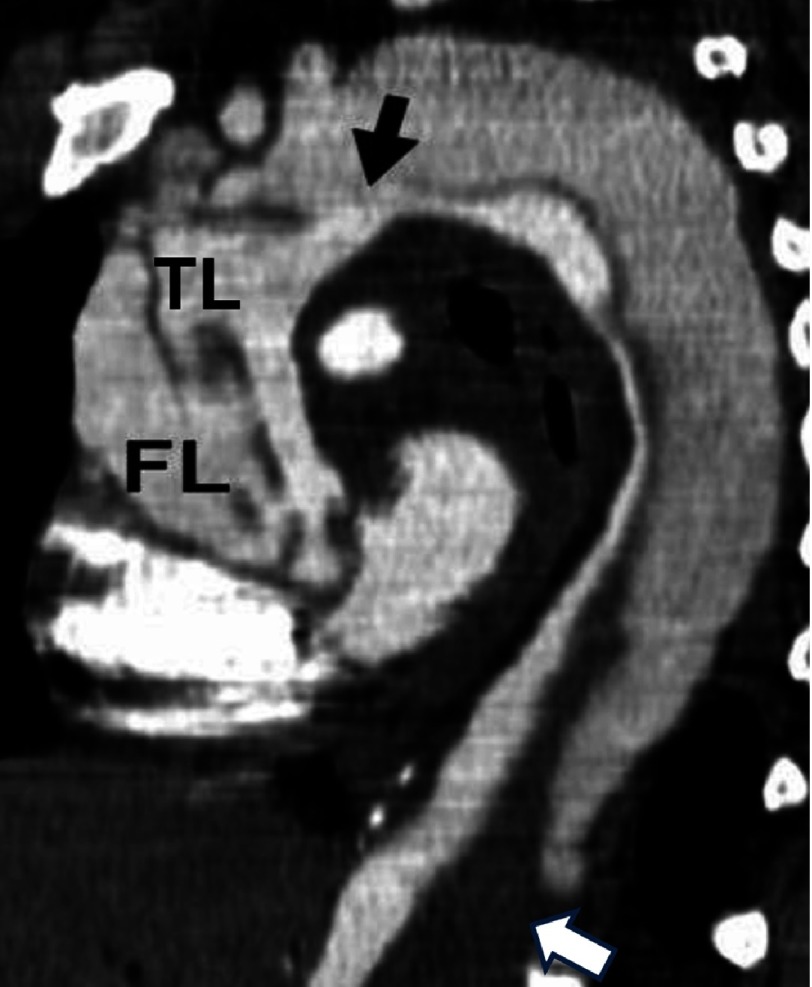
CT shows a type A AAD with a large entry tear in the aortic arch (black arrow) and retrograde dissection to the ascending aorta and antegrade descending thoracic aorta dissection with distal total thrombosis of false lumen (white arrow).Abbreviations: TL= true lumen, FL= false lumen.